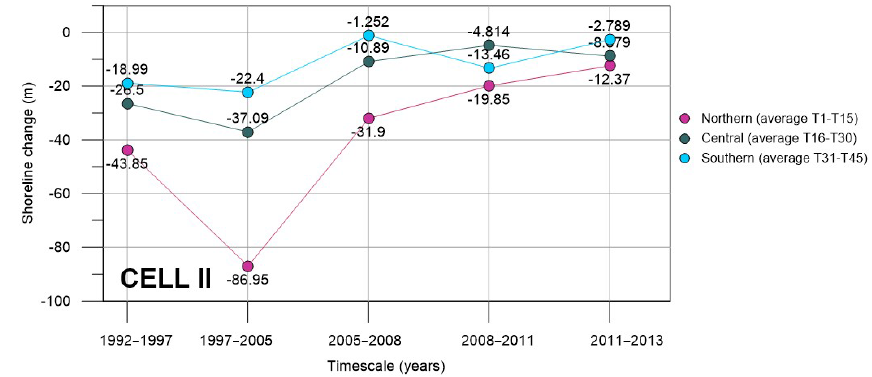
Figure 9. Average shoreline position in northern, central and southern sectors of Cell